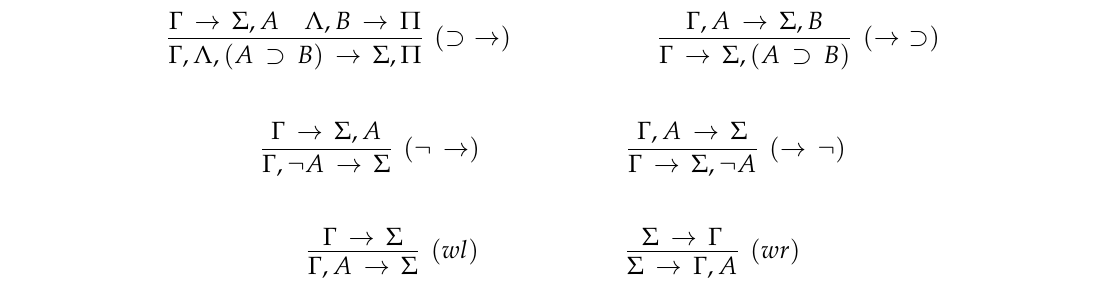
Figure 5. Rules of the sequent calculus LK .